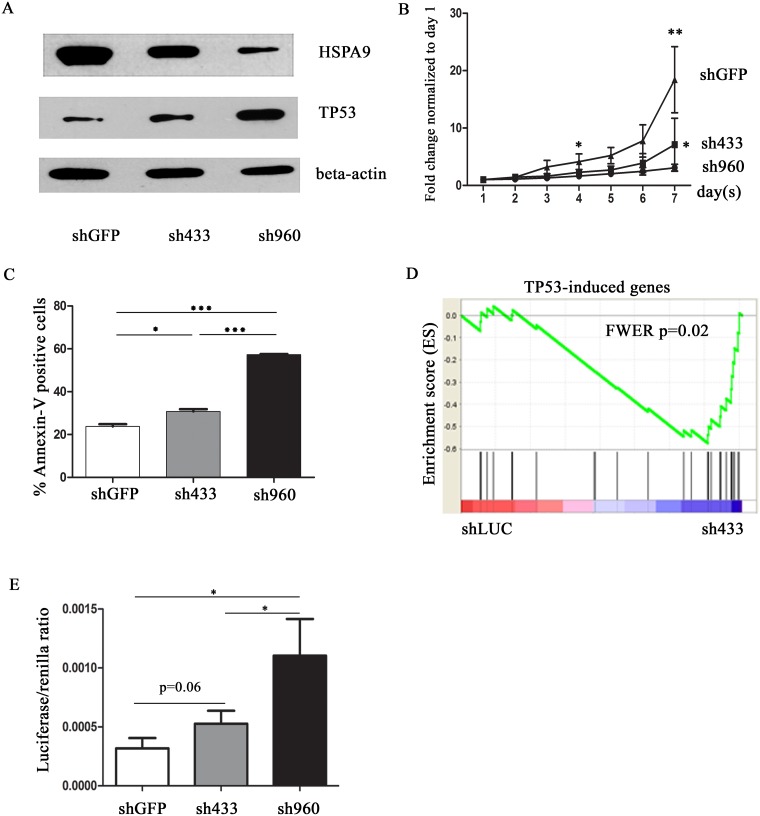
Knockdown of HSPA9 increases TP53 expression and activity in CD34+ cells.(A) Representative immunoblot of HSPA9 and TP53 protein in CD34+ cells transduced with shRNAs targeting a control gene (GFP) or HSPA9 after 7 days in erythroid culture conditions. (B) Transduced cells were seeded at equal concentrations in erythroid culture media and the total number of cells was counted daily in the presence of puromycin selection. The fold change in cell counts was calculated relative to the number of cells on day 1 (n = 3 independent replicates for each shRNA). (C) Quantification of Annexin V+ cells (a surrogate for apoptosis) following knockdown of HSPA9 in CD34+ cells (n = 3 for each shRNA). (D) Gene Set Enrichment Analysis (GSEA) enrichment score plot for 26 annotated TP53-induced genes. Individual genes in the gene set are represented by a black vertical bar in the middle of the plot. (E) TP53 luciferase reporter assay showed a dose-dependent increase in TP53 activity following HSPA9 knockdown (n = 3). LUC, luciferase. * p<0.05, ** p<0.01, *** p<0.001.